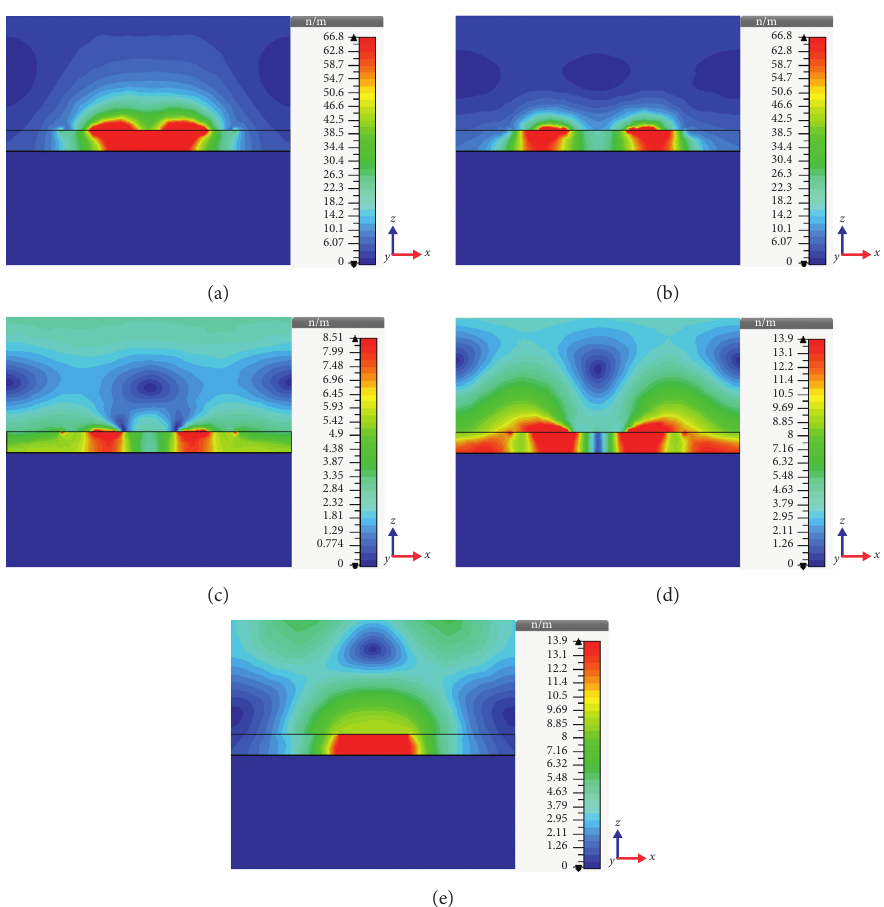
Figure 7: Magnetic field [abs H ] distribution on x – z plane for different peaks: (a) 5.984GHz, (b) 12.232GHz, (c) 18.128GHz, (d) 18.414 GHz, and (e)